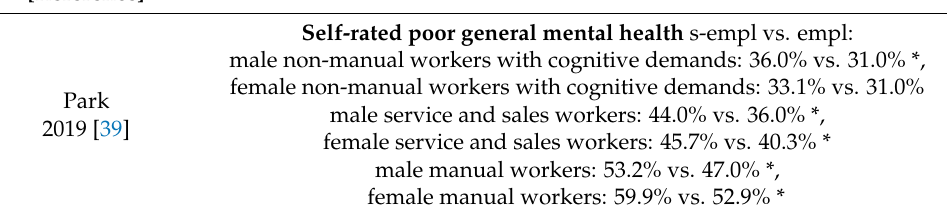
female service and sales workers: 45.7% vs. 40.3% * male manual workers: 53.2% vs. 47.0% *, female manual workers: 59.9% vs. 52.9%